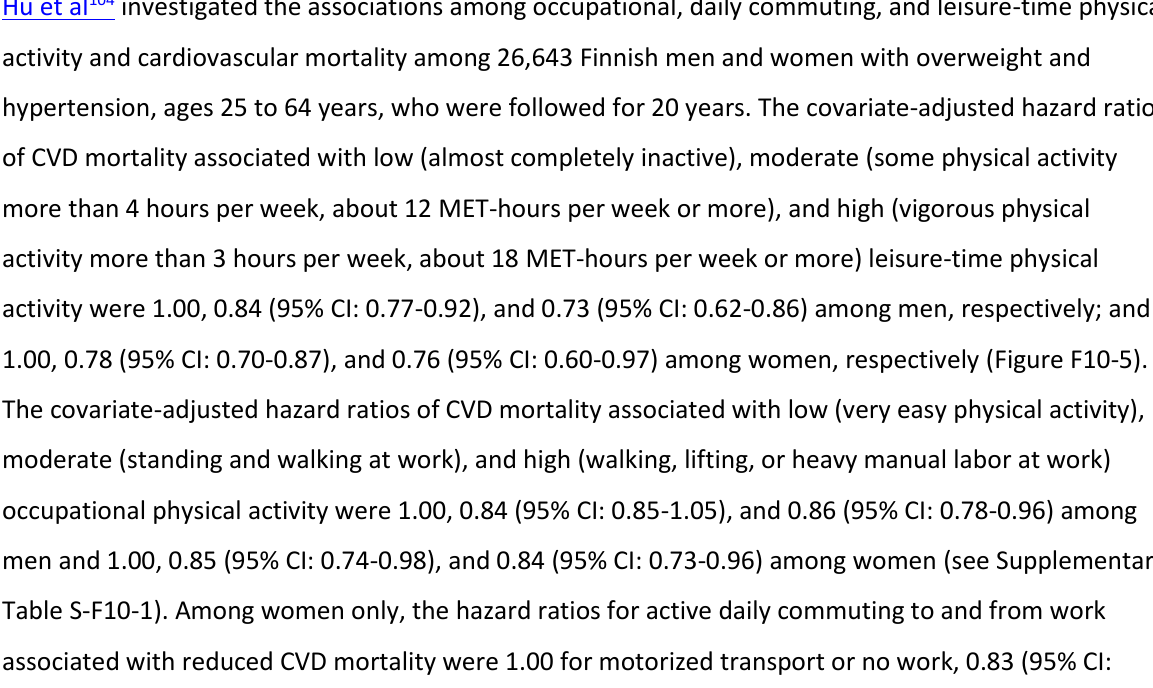
Table S-F10-1). Among women only, the hazard ratios for active daily commuting to and from work associated with reduced CVD mortality were 1.00 for motorized transport or no work, 0.83 (95% CI: 0.72-0.96) for walking or bicycling 1 to 29 minutes per day, and 0.86 (95% CI: 0.74-0.99) for 30 or more minutes per